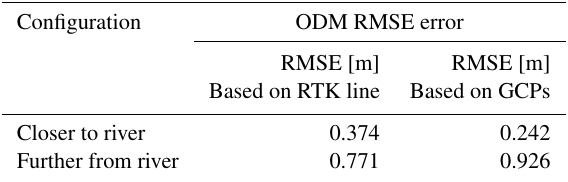
Table 3. RMSE comparison further from and closer to the